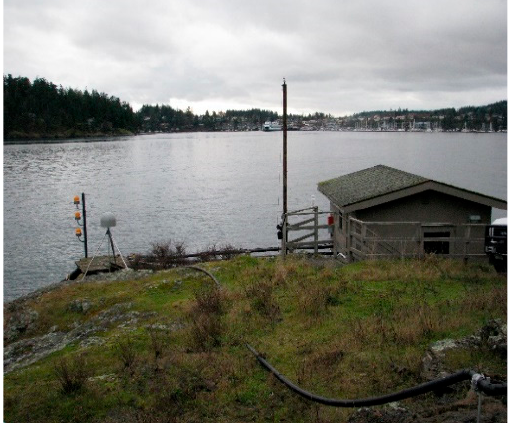
Figure 2. The ssc02 station’s surrounding environment.